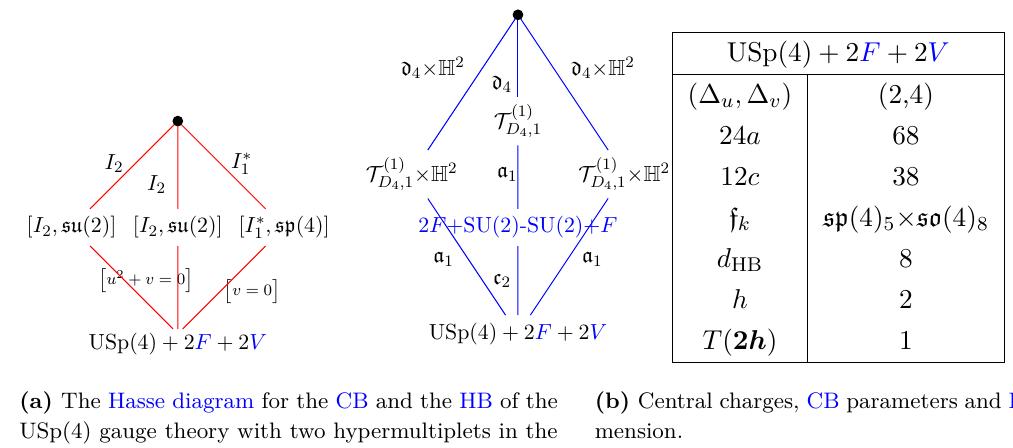
Figure 37. Information about the USp(4) N = 2 theory with two hypermultiplets in the 4 ⊕ 5 .